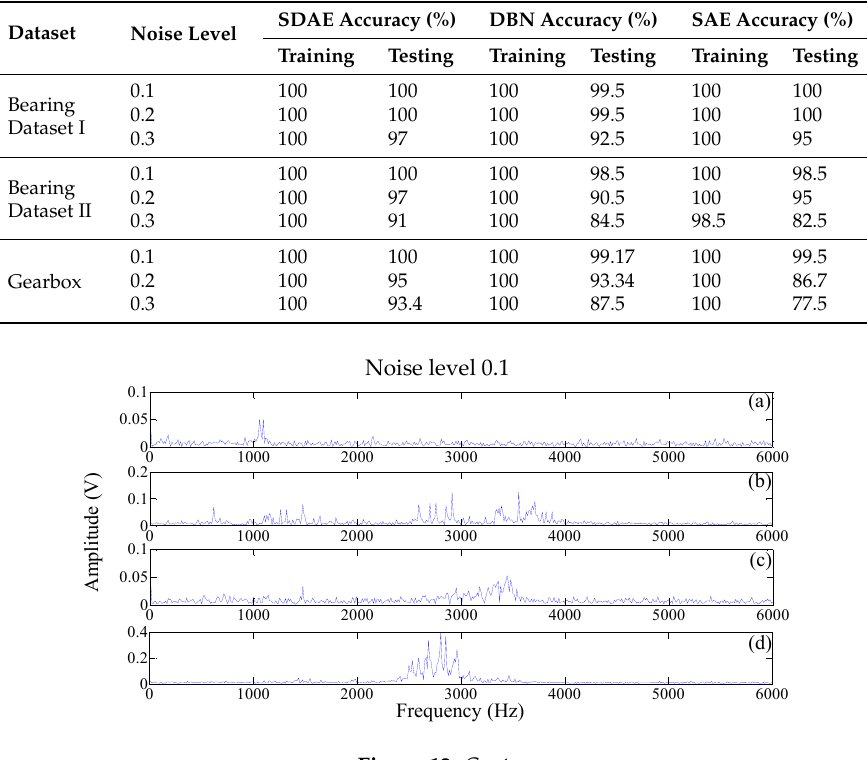
Table 8. Recognition accuracy on different levels of noise interferences.